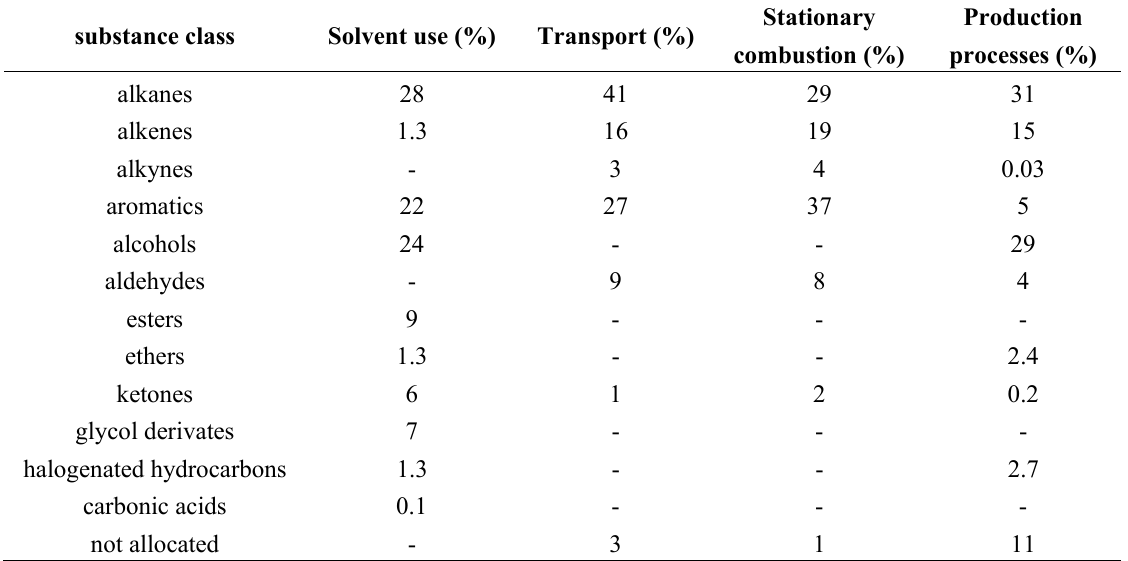
Table 8. Division of emissions to substance classes (data from Germany 1998) for different emission sectors [342]. substance class Solvent use (%) Transport (%)